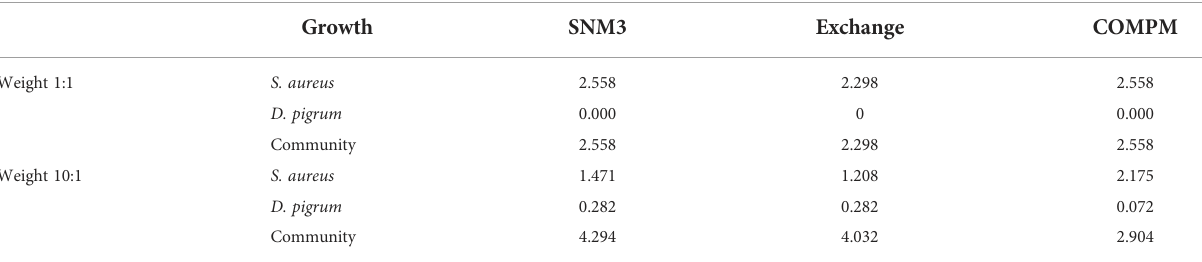
TABLE 2 Comparison of growth rates of species D. pigrum and S. aureus and their community growth in the compartmentalized community. 111 total exchange reactions and all shared uptake and secretion reactions Growth